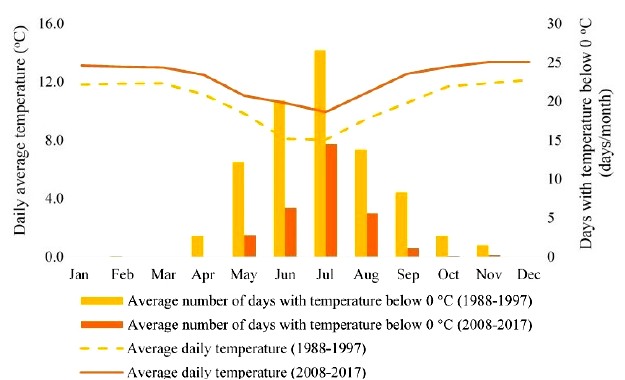
Fig. 3 . Monthly average temperature and number of days with temperature below 0 °C for the periods of 1988 to 1997 and 2008 to 2017 in the Lari